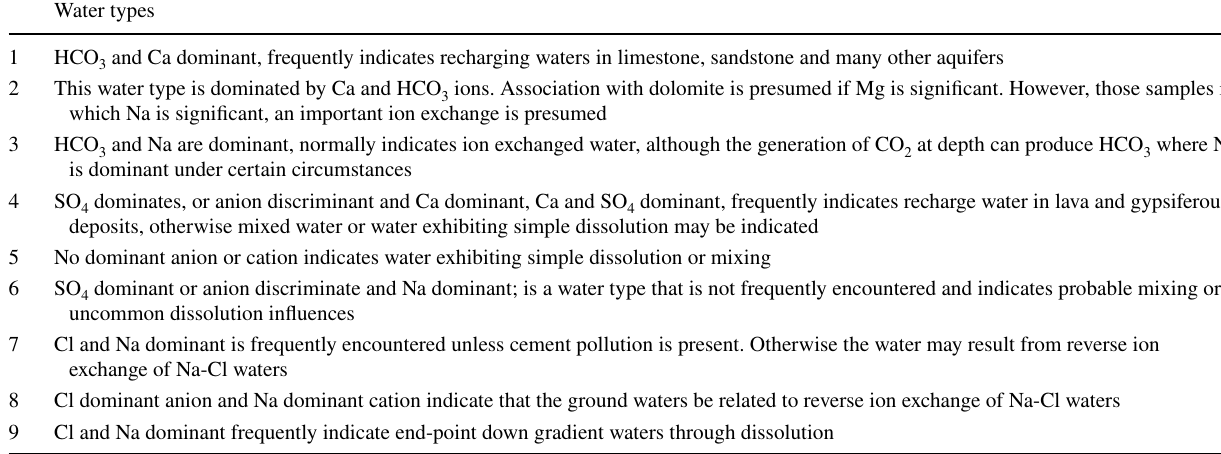
Table 3 Classification of water based on Durov diagram (Lloyd and Heathcote, 1985) Water